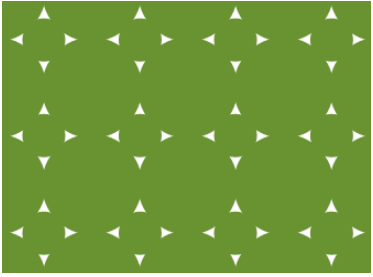
Figure 2. Tangent arrangement of rock particles under compaction.